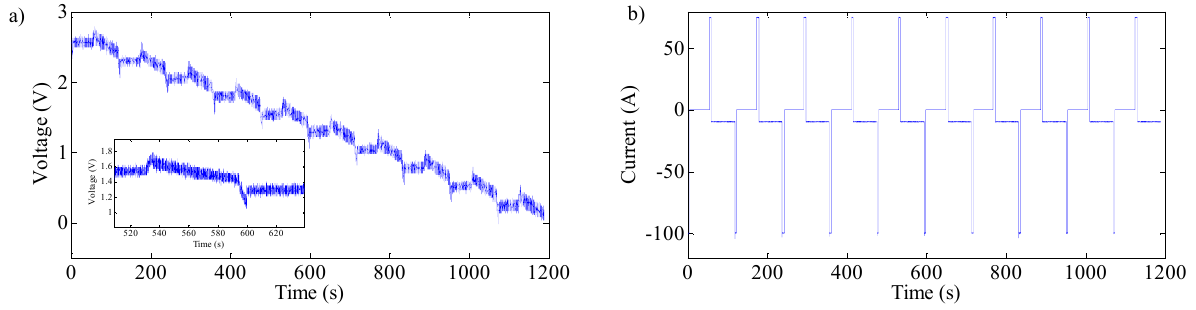
Figure 8. The measured voltage ( a ) and current ( b ) profiles in the HPPC test.